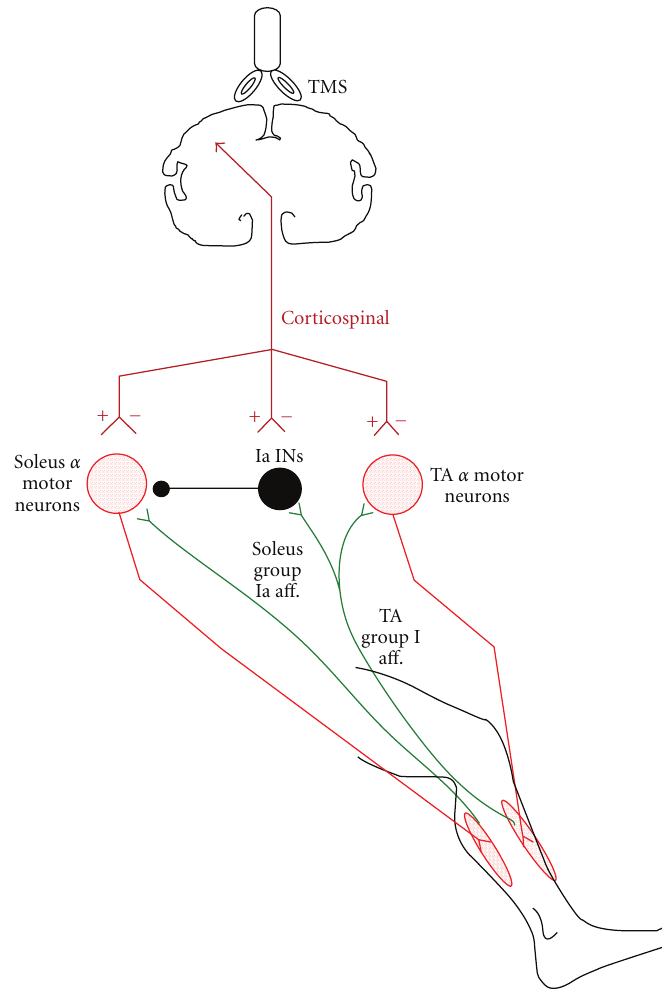
Figure 1: Schematic illustration of cortical control of spinal reflex circuits and spinal interneuronal circuits investigated after 60 sessions of locomotor training in the same SCI subject. The soleus H-reflex evoked by posterior tibial nerve stimulation, tibialis anterior (TA) muscle motor evoked potential (MEP), soleus H-reflex conditioned by subthreshold transcranial magnetic stimulation (TMS) delivered at an optimal site (“hot spot”) for evoking an MEP in the right soleus muscle, soleus H-reflex depression by common peroneal nerve stimulation that is mediated by Ia inhibitory interneurons (Ia INs; reciprocal inhibition), and the reciprocal inhibition conditioned by subthreshold TMS delivered at an optimal site (“hot spot”) for evoking an MEP in the right TA muscle were all investigated in the same patient at rest and/or during assisted stepping after locomotor training. Open triangles indicate excitatory synapses, while the filled circle indicates inhibitory synapses. The cortical control on these spinal circuits is indicated as a synapse that may increase (+) or decrease ( − ) actions of flexor-extensor α motor neurons and/or Ia inhibitory